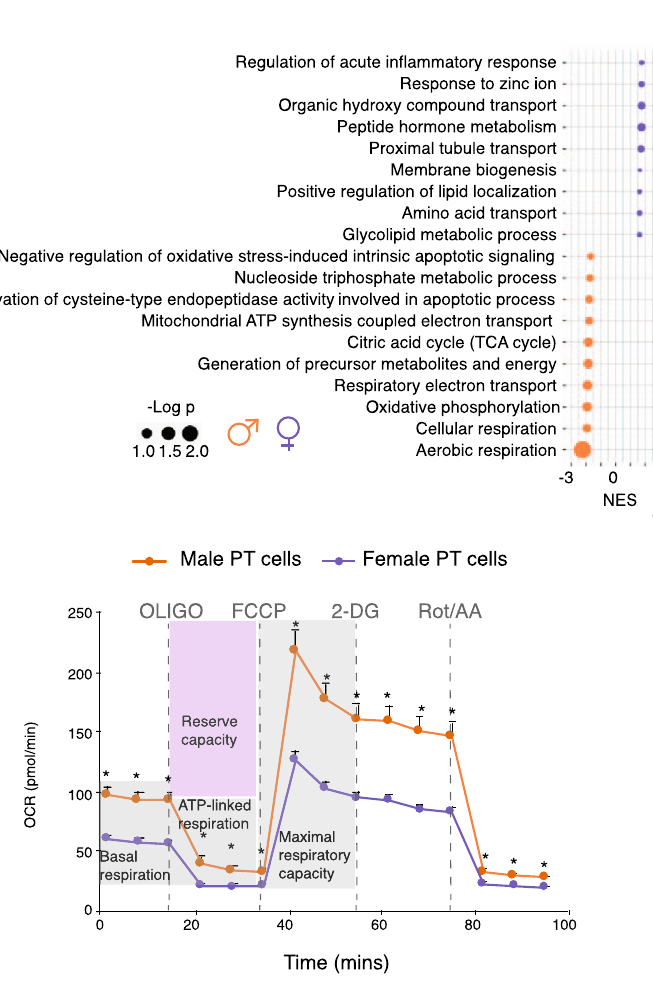
Fig. 3 | Sex differences in mitochondrial respiration and energy precursor metabolism of proximal tubular cells. a Depiction of selected signi fi cant (FDR<0.25) terms identi fi ed by GSEA analysis as being enriched in males and females, respectively. Source data are provided in Supplementary Data 3. P